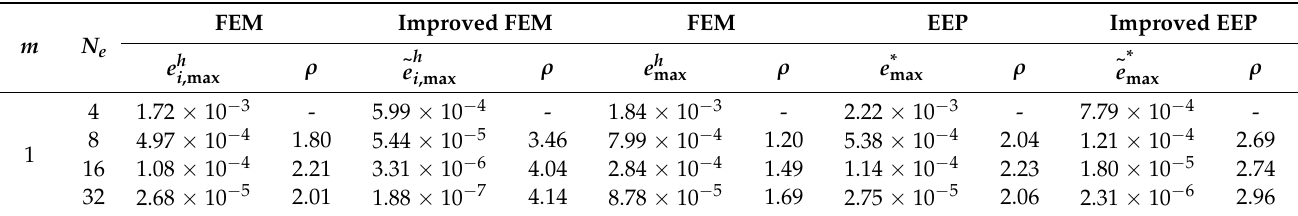
Table 1. Convergence orders of